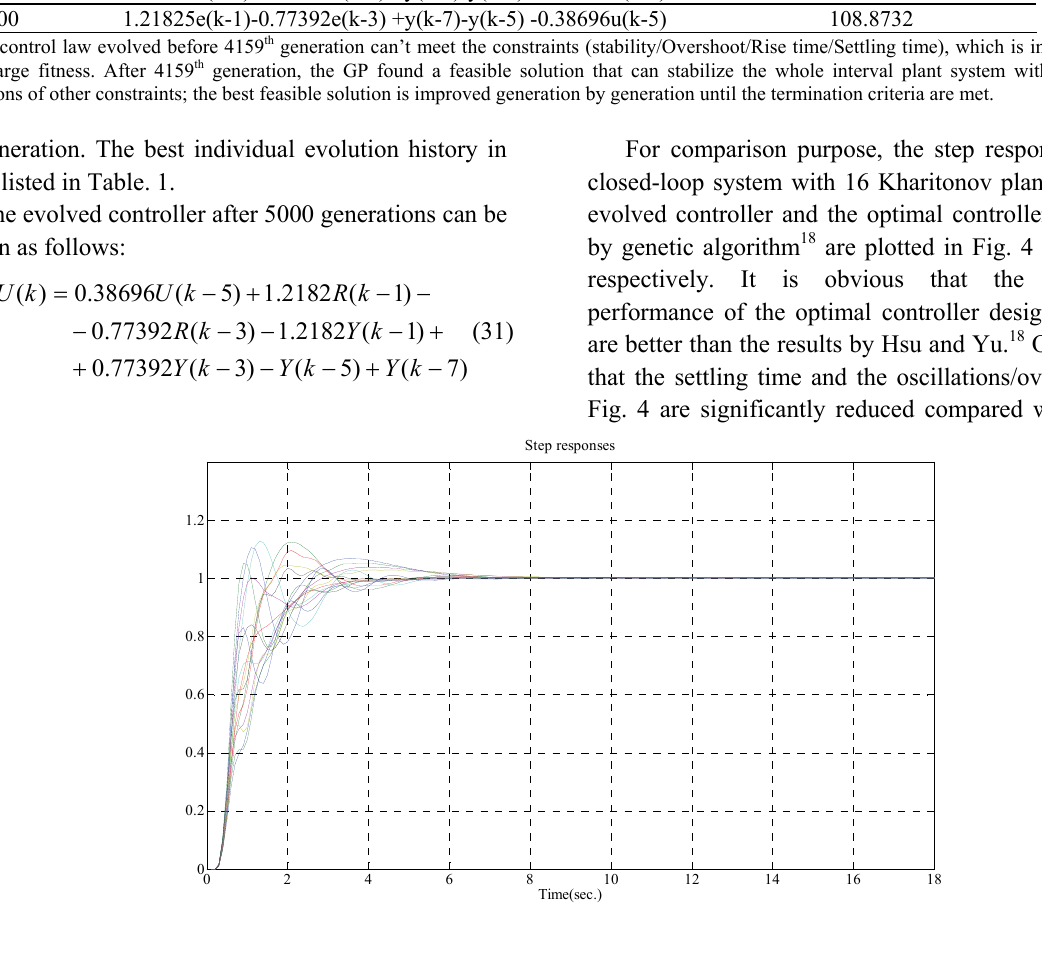
Fig.4. Step responses with all 16 Kharitonov plants by GP evolved controller